Question: Summarize what this figure shows in one sentence.
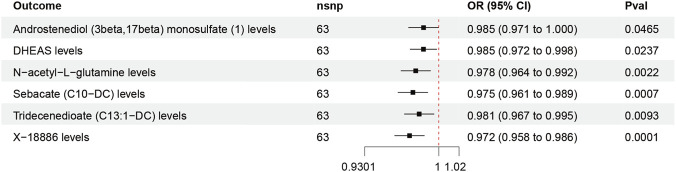
Answer: Exploratory reverse MR analysis of POI-related genetic liability and circulating metabolites. The forest plot shows nominal POI-to-metabolite associations estimated using the IVW method. Reverse MR was performed as a secondary directionality analysis and was not interpreted as definitive evidence of reverse causality. Sebacate showed discordant directionality between forward and reverse MR and was not prioritized for protective functional screening.